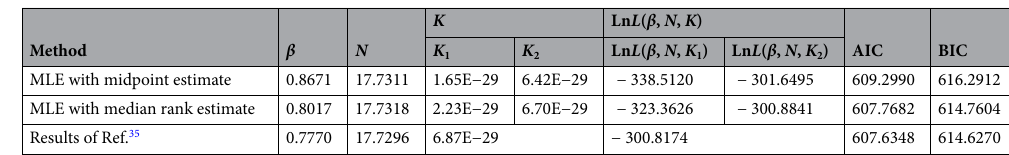
Table 3. Results comparison for model parameters with the different